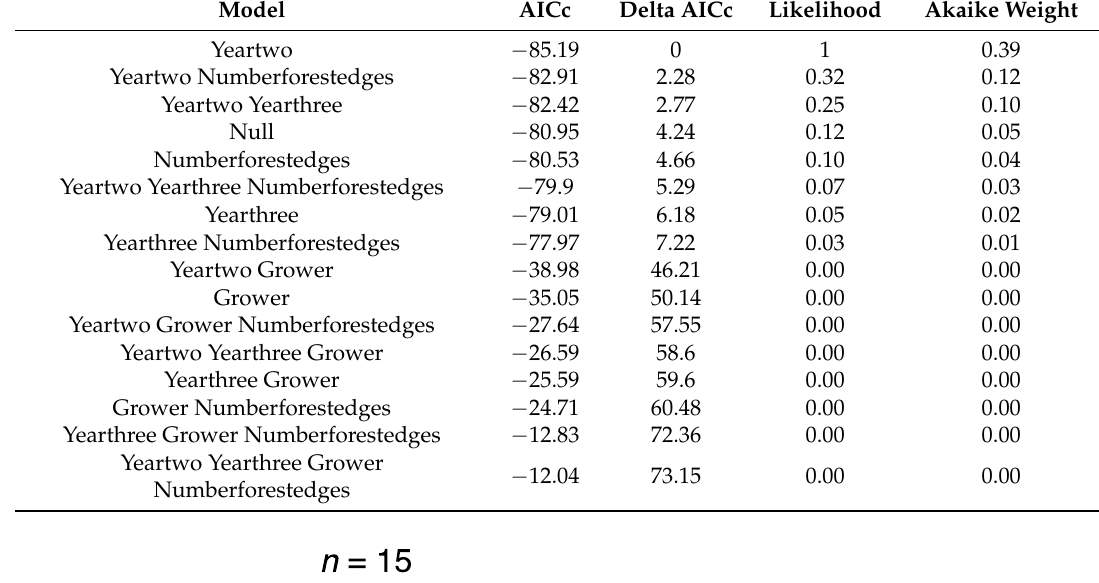
Table 4. Models compared for influences-on-bird-damage to grapes.